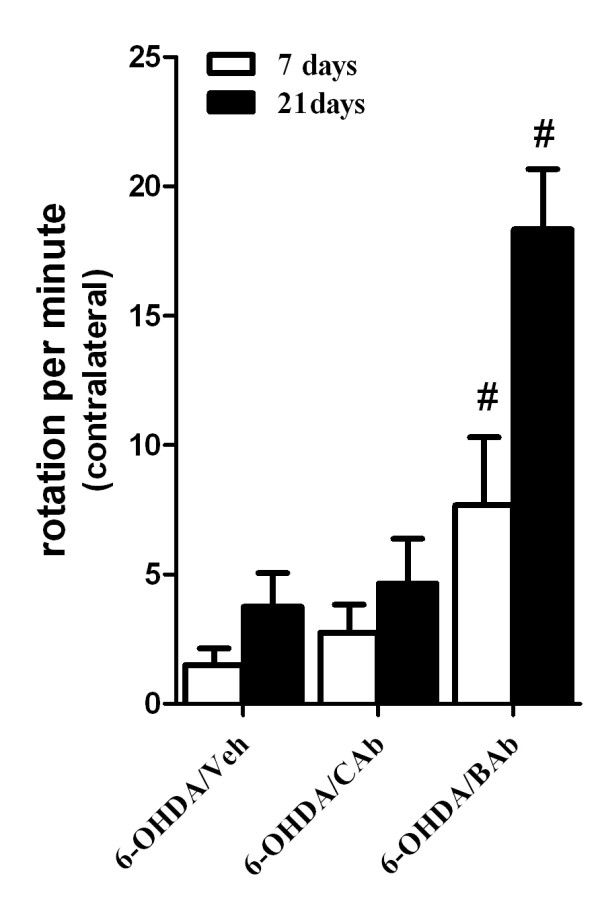
BAb exacerbates 6-OHDA-induced behavioural deficits. Contralateral rotation measurements following administration of apomorphine in each experimental group are shown in bar graph at 7 days and 21 days post-6-OHDA injection. Data are presented as mean ±S.E.M (n = 5 rats/group). (#)Statistical differences from 6-OHDA/Veh- or 6-OHDA/CAb-treated animals are P < 0.001.